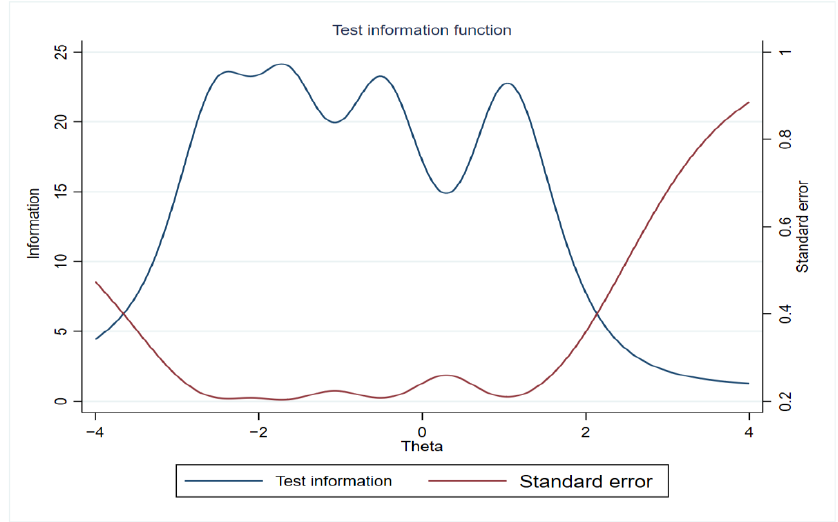
Figure 3. Test information function. Figure 4 is the matrix diagram of the project characteristic curve (ICC) of each item. Under ideal conditions, the first and fifth curves of ICC change monotonously, and the second and fourth curves are normal distribution. The results show that the ICC